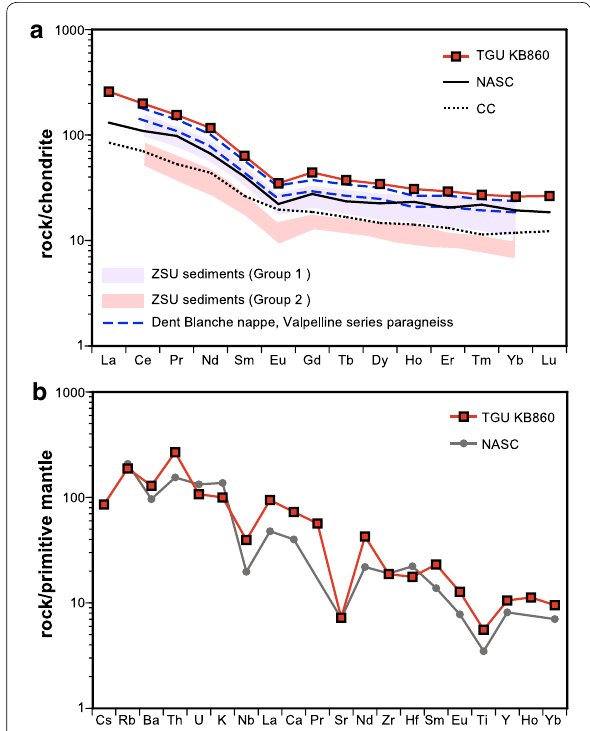
Fig. 10 Trace element composition of garnet-phengite schist KB860. a Chondrite-normalized REE patterns. Chondrite data for normalization from McDonough and Sun (1995). For comparison NASC (North American shale composite) from Gromet et al. (1984); CC (continental crust) from Rudnick and Gao (2003), ZSU metasediments (Group 1 and 2 from Mahlen et al. 2005), paragneiss from the Valpelline series of the Dent Blanche nappe (Mahlen et